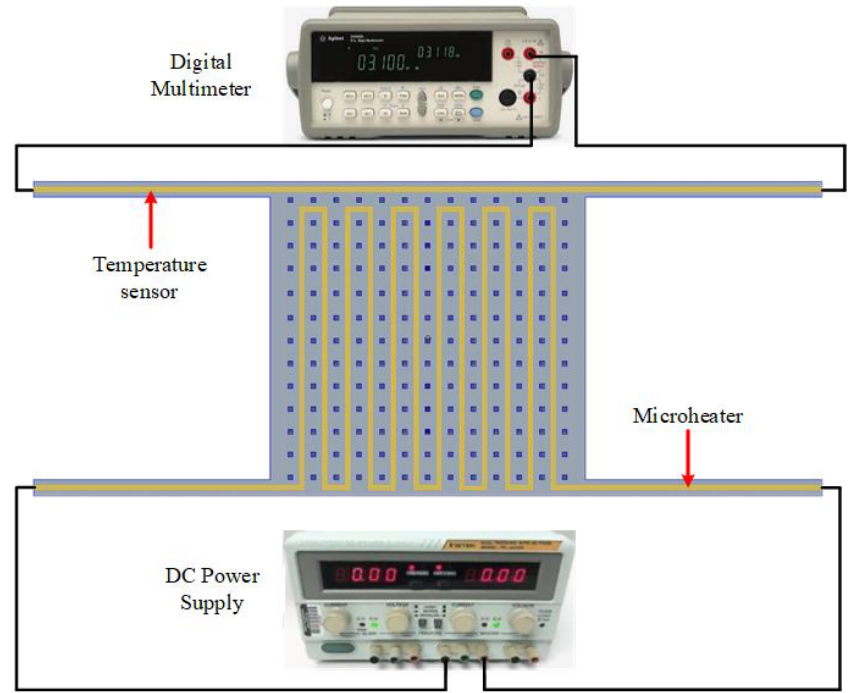
Figure 14. Schematic of the resistance versus voltage measurement.